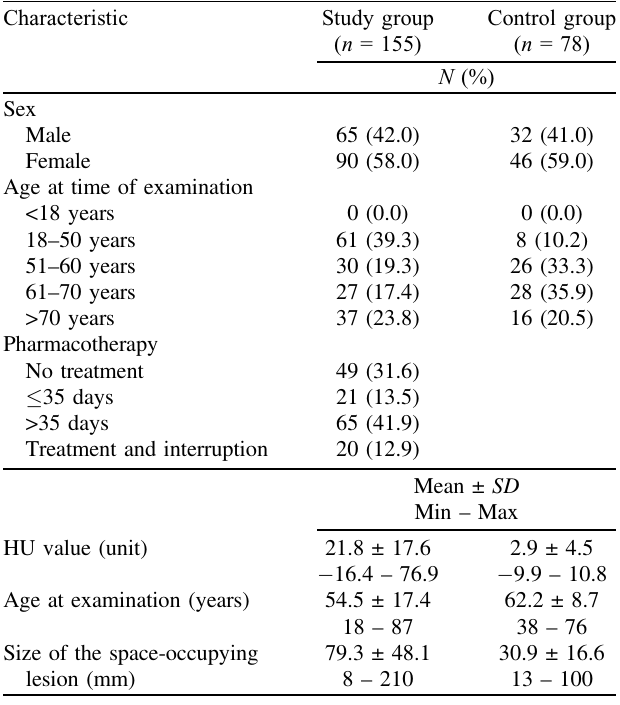
Table 2. HU values in the study group ( n = 155) according to primary morphological type and in the control group ( n = 78).